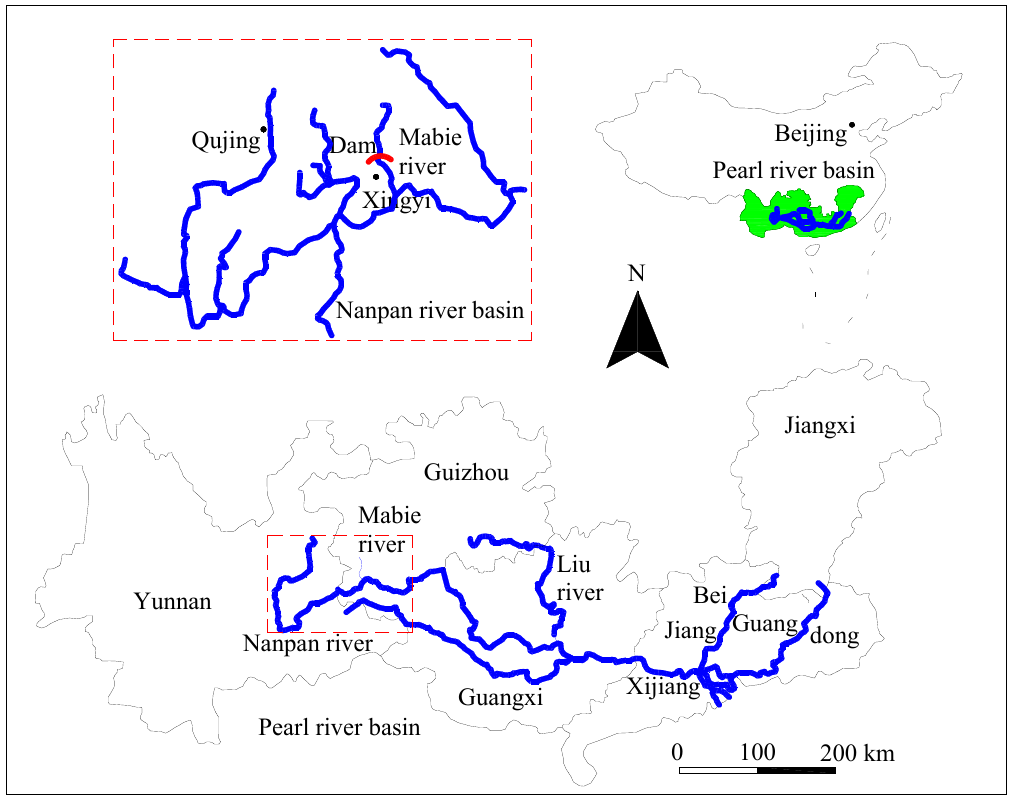
Figure 1. Location of study area.